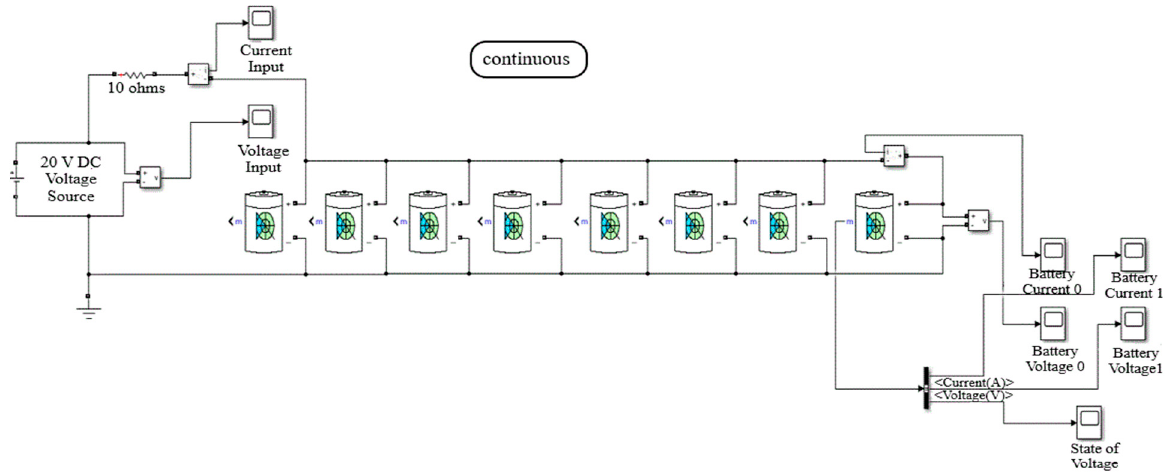
Figure 17. Our Simulink Simulation of the Storage Subsystem (Charging).